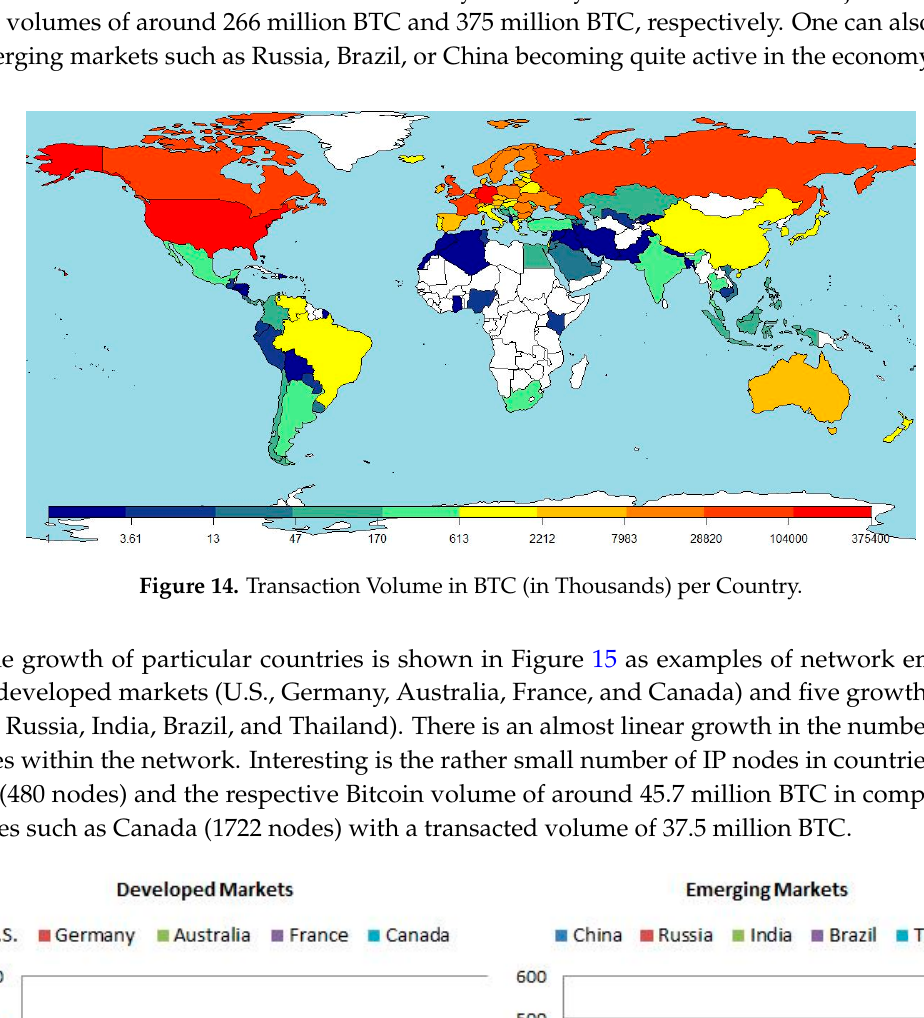
Figure 13. Global Distribution of Geo ‐ located Internet Protocol (IP) Nodes.